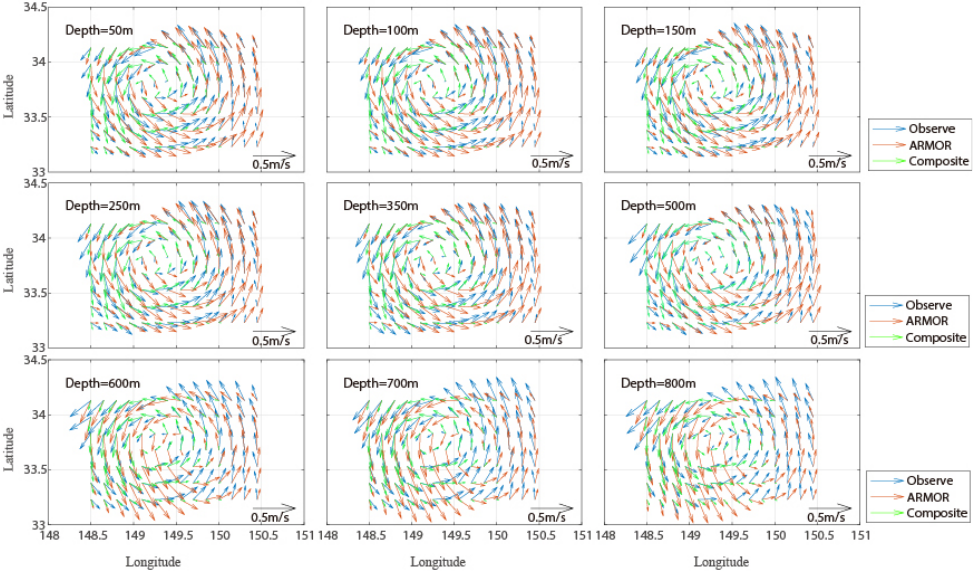
Figure 12. Geostrophic Vector (The blue arrow is observation data; the red arrow is the ARMOR3D data; the green arrow is the composite data).